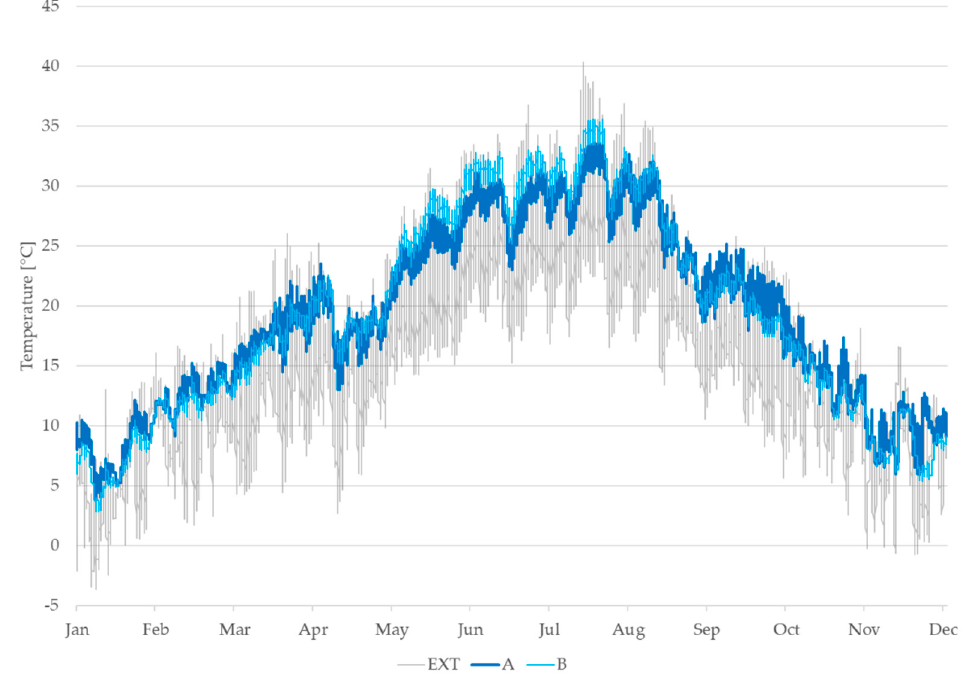
Figure 8. Time profiles of T values measured in 2017 in positions A (Lungarno), B (Ponte Vecchio), and outdoor (EXT).